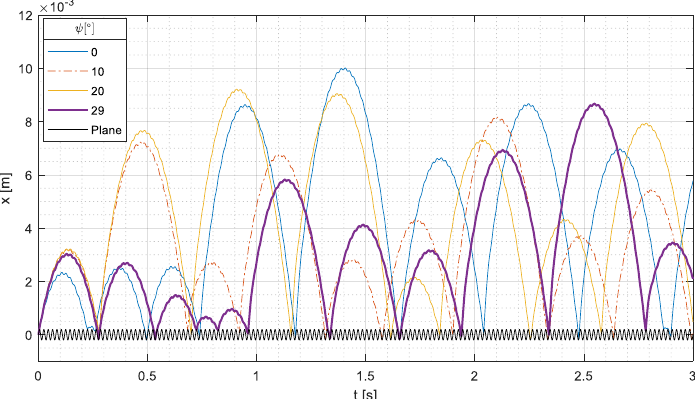
Figure 6. Numerical results, displacement of the cylindrical part along the track, 𝜃 = 3° , 𝑓 𝑣 = 0.005 , 𝜇 𝑐 = 0.3, 𝜇 𝑠 = 0.6, and parametric values of 𝜓 .